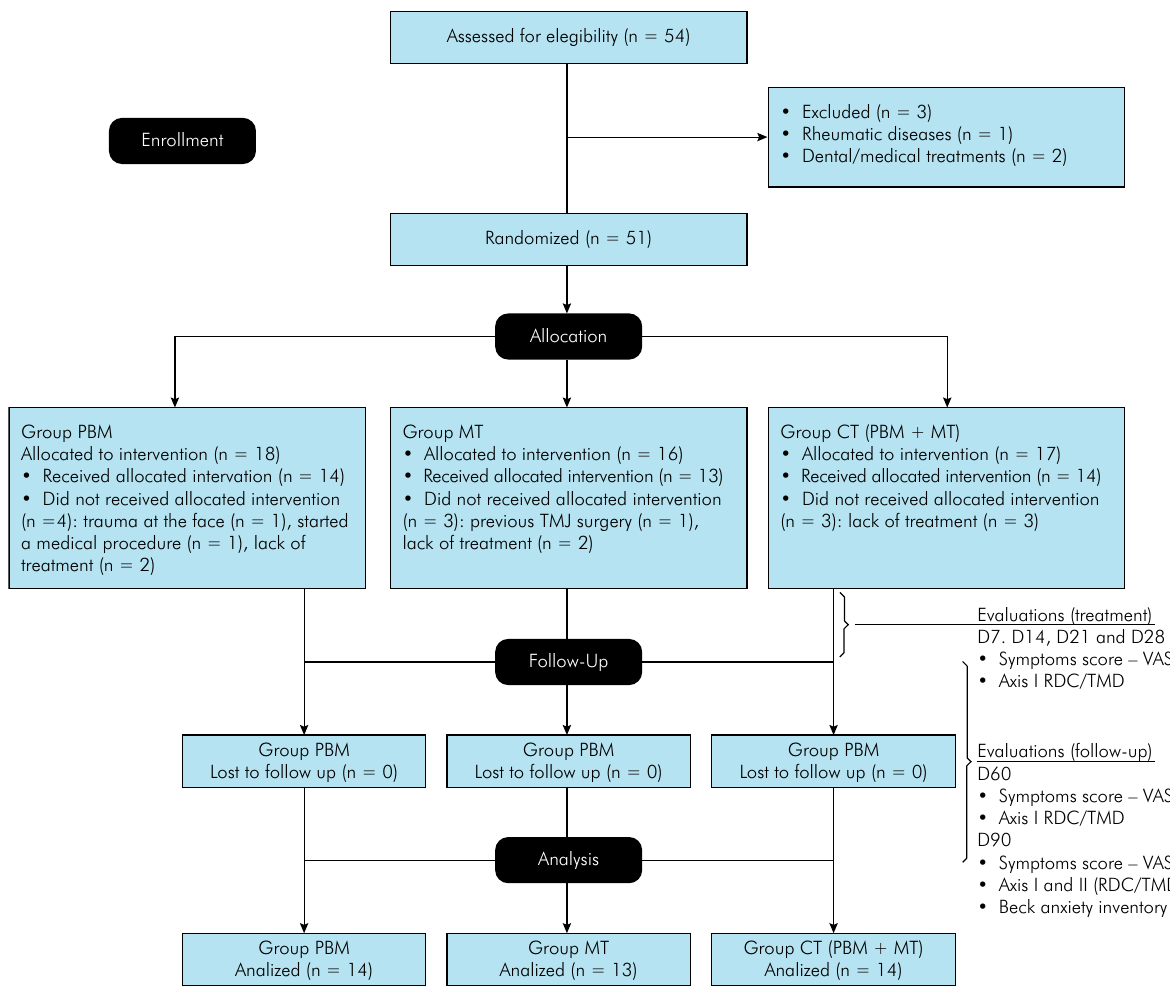
Figure 1. Flowchart showing subject enrollment and